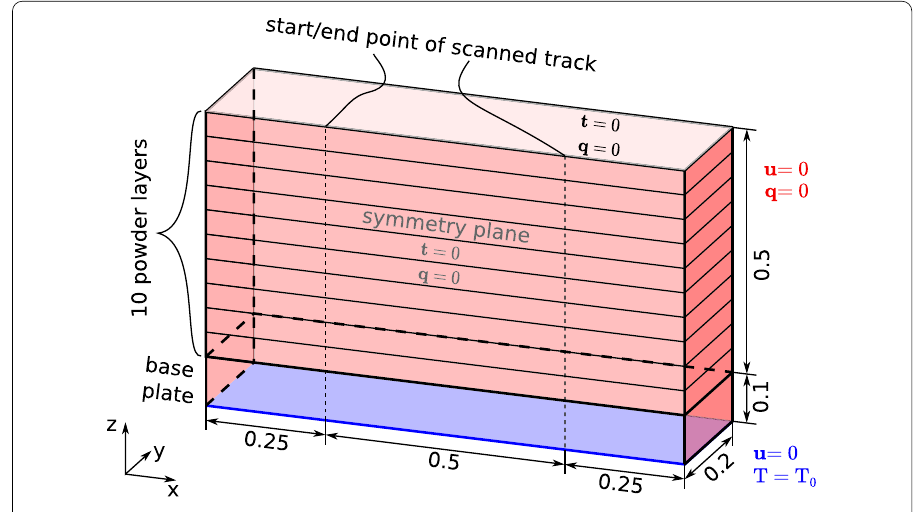
Fig. 14 Geometry, boundary conditions and simulation setup of ten layer example. Dimensions in mm